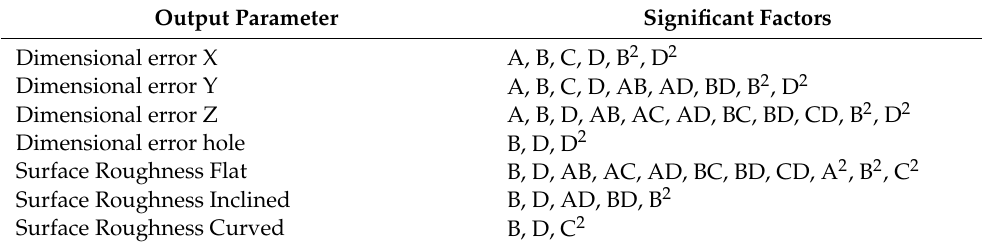
Table 4. Factors significantly affecting output